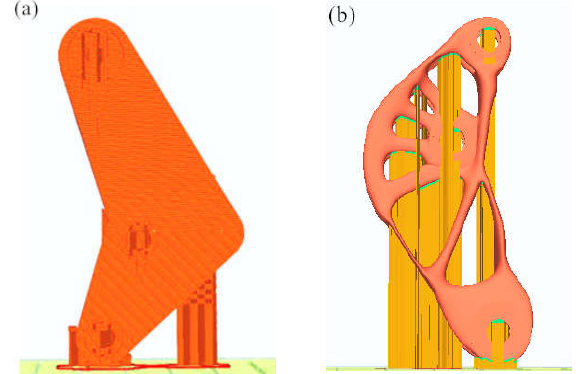
Figure 7. Effect of data processing and support addition: ( a ) Original model and ( b ) Manual reconstruction model.